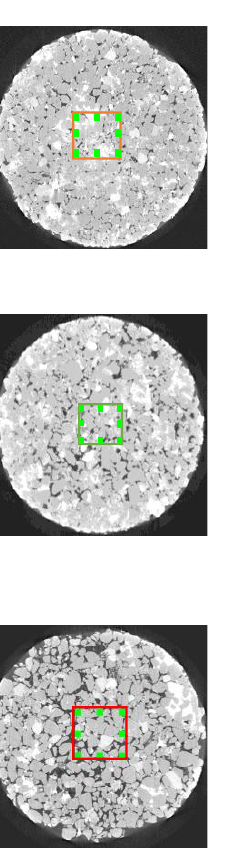
Figure 6. Results of REV analysis in terms of porosity spatial correlation (right), performed on three parts of the whole core domain defined in Figure 5, based on the REV central cutting method explained in Figure 5 with top view presented on the left.